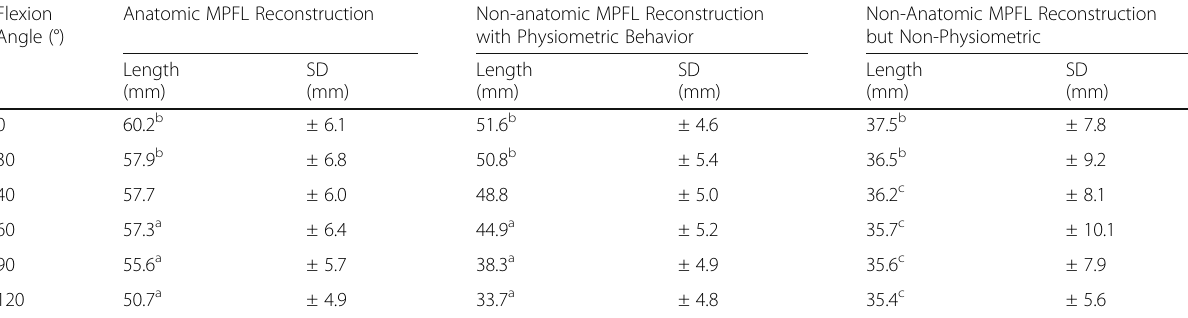
Table 3 Distance between the patellar and femoral insertion points for the MPFL reconstruction techniques analyzed Flexion Anatomic MPFL Angle (°)